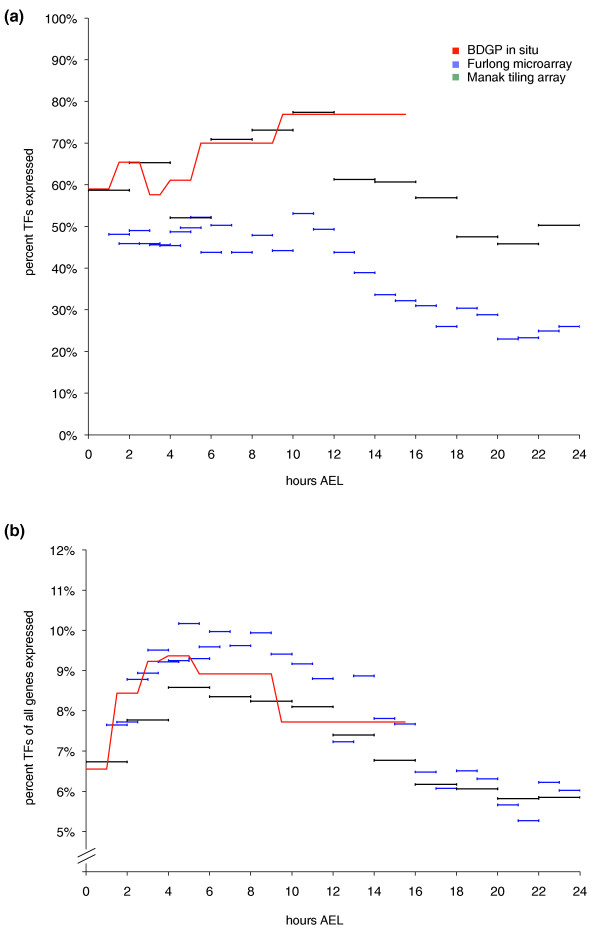
Temporal utilization of site-specific transcription factors. (a) Percentage of the TF repertoire used during embryonic development. Samples were taken at various degrees of granularity (red, BDGP in situ database; blue, embryonic microarray gene expression time-course; green, active transcription map). Although there are differences in the absolute number of transcribed TFs, there is good agreement in the general trends. About half of the TFs are maternally contributed. The peak of TF expression is around 10 to 12 h AEL, and the number of expressed TFs declines towards the end of embryogenesis. (b) Proportion of TFs in the group of expressed genes. The ratio of TFs versus non-TFs is highest between 2 and 6 h AEL. This coincides with the functional compartmentalization of the germ layers leading to the development of various organ systems.